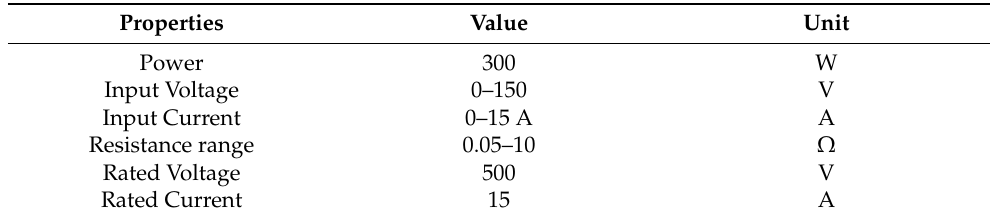
Table 3. BK 8500B Specifications.